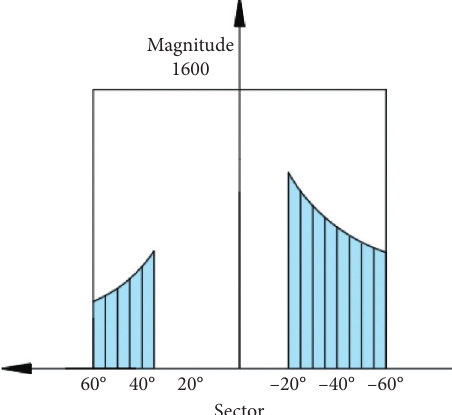
Figure 20: The polar histogram based on risk